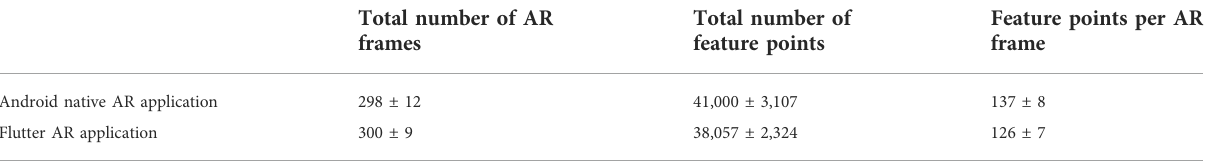
TABLE 6 Feature point tracking quality benchmark.